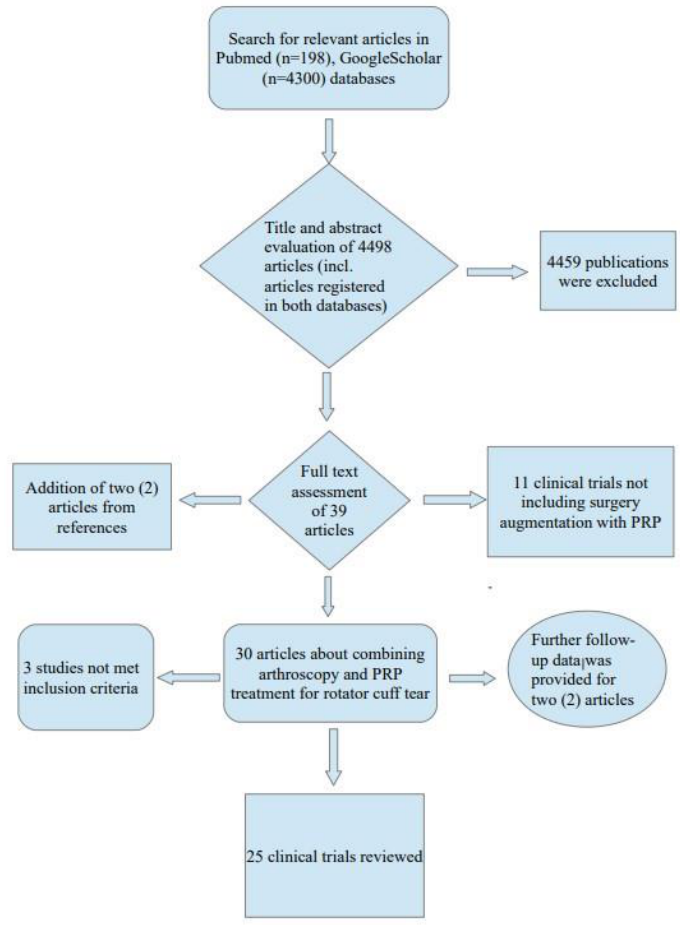
Figure 1. Figure 1. Flowchart.